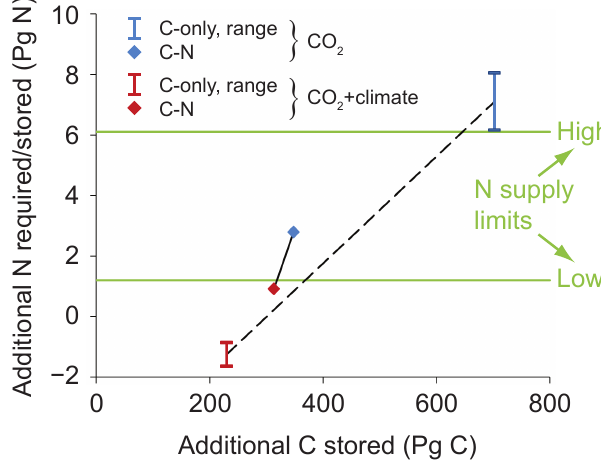
Fig. 7. Nitrogen required to support terrestrial carbon uptake be- tween 2000 and 2100 simulated in the C–N and C-only simulations under CO 2 -only and CO 2 -and-climate-change scenarios based on RCP 8.5 radiative forcing of the MPI-ESM-LR general circulation model (GCM). High and low N supply limits proposed by Hungate et al. (2003) are shown. For C-only the upper N-requirement value assumes a fixed tree C:N of 200 following Hungate et al. (2003), the lower value that all new tree carbon is allocated to wood with a C:N of 500. Soil is assumed to have a fixed C:N of 15. For C–N, N requirements are as simulated by the